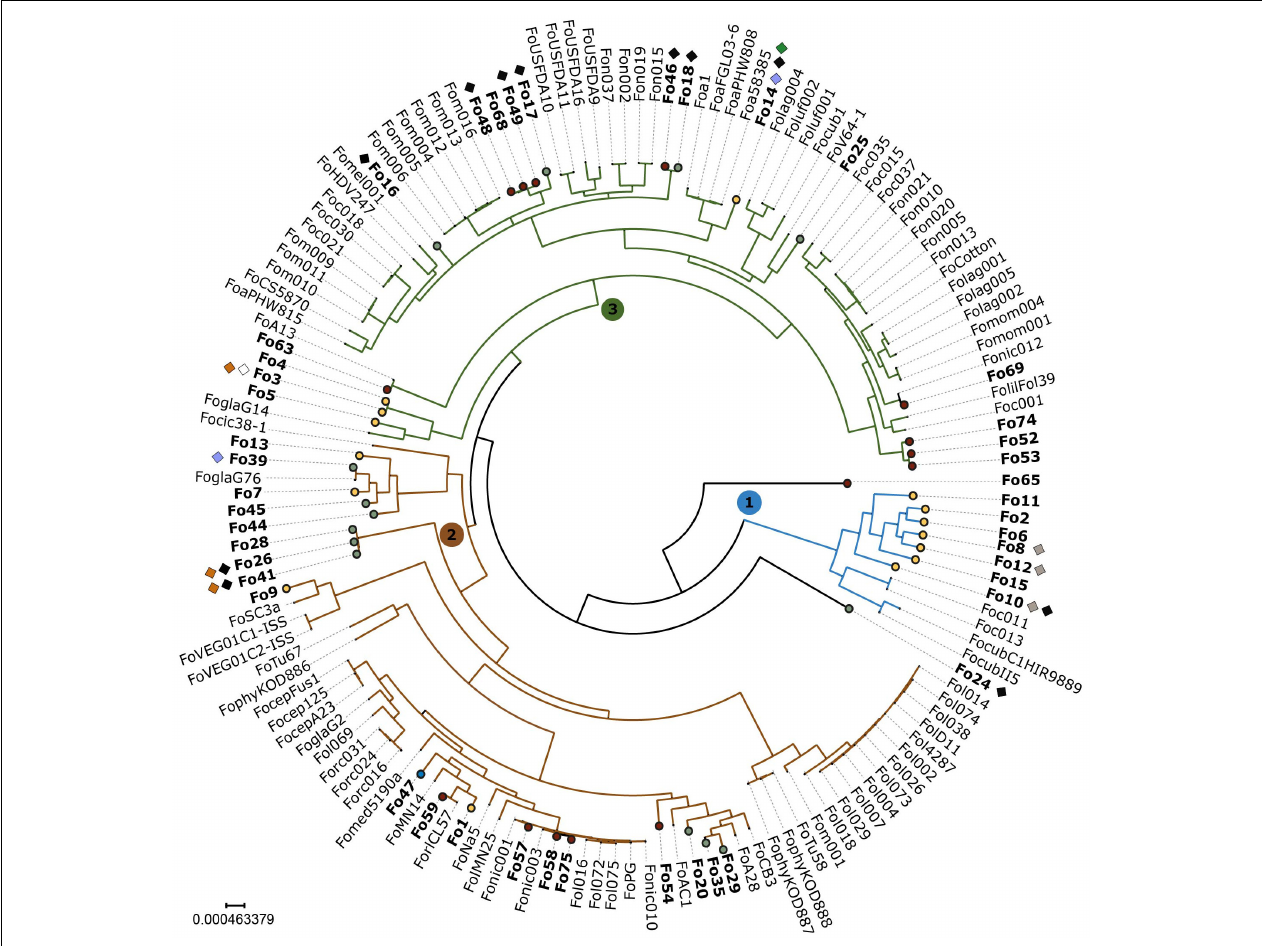
FIGURE 2 | Endophytic Fo have a polyphyletic origin with an unequal distribution among the three clades. In this maximum-likelihood phylogeny based on a concatenated alignment of 3003 conserved genes, three major clades representing different phylogenetic species, are numbered 1, 2, 3 and colored in blue, green, and red. Endophytic strains sequenced for this study are shown in bold and represented with circles. Circles are color-coded according to habitat: yellow – Australia; green – Spain; maroon – United States; blue – France (reference endophytic strain Fo47). Endophytes are polyphyletic: all three major clades contain endophytes. Endophytes from different habitats cluster together (e.g., Fo46 and Fo18), and endophytes cluster with pathogens (e.g., Fo59 with ForlCL57). Presence of known effector genes is indicated with diamonds and colored as follows: white – SIX1 ; gray – SIX2 ; blue – SIX6 ; black – SIX9 ; orange – SIX14 ; and green – AVRFOM2 . Fusarium fujikuroi IMI58289 was used as an outgroup to root the tree and then